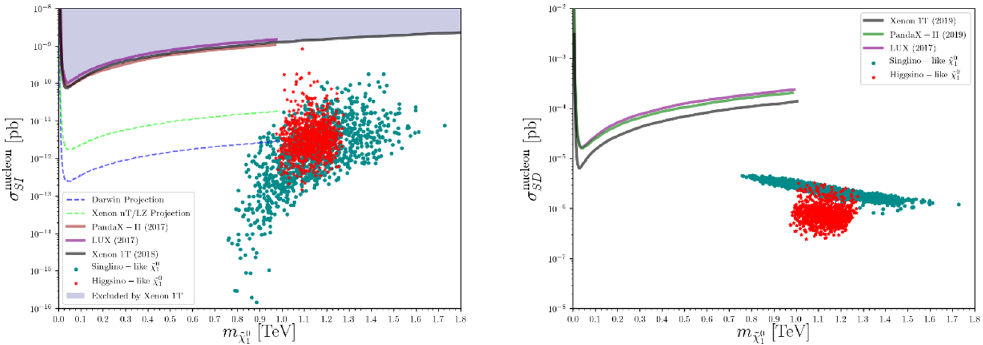
Figure 7 . DM-neutron SI (left) and SD (right) scattering cross section as a function of the mass of the WIMP candidate (neutralino LSP). The colour bars show the composition of the LSP. Limits from current (solid) and future (dashed) experiments are also